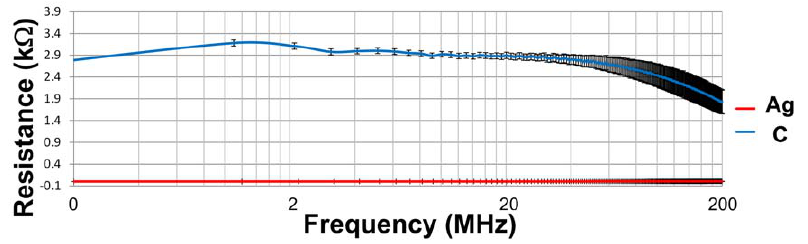
Figure 6. Electrical Impedance spectroscopy study of the traces. Resistivity of the PTF traces from 100 Hz to 200 MHz.